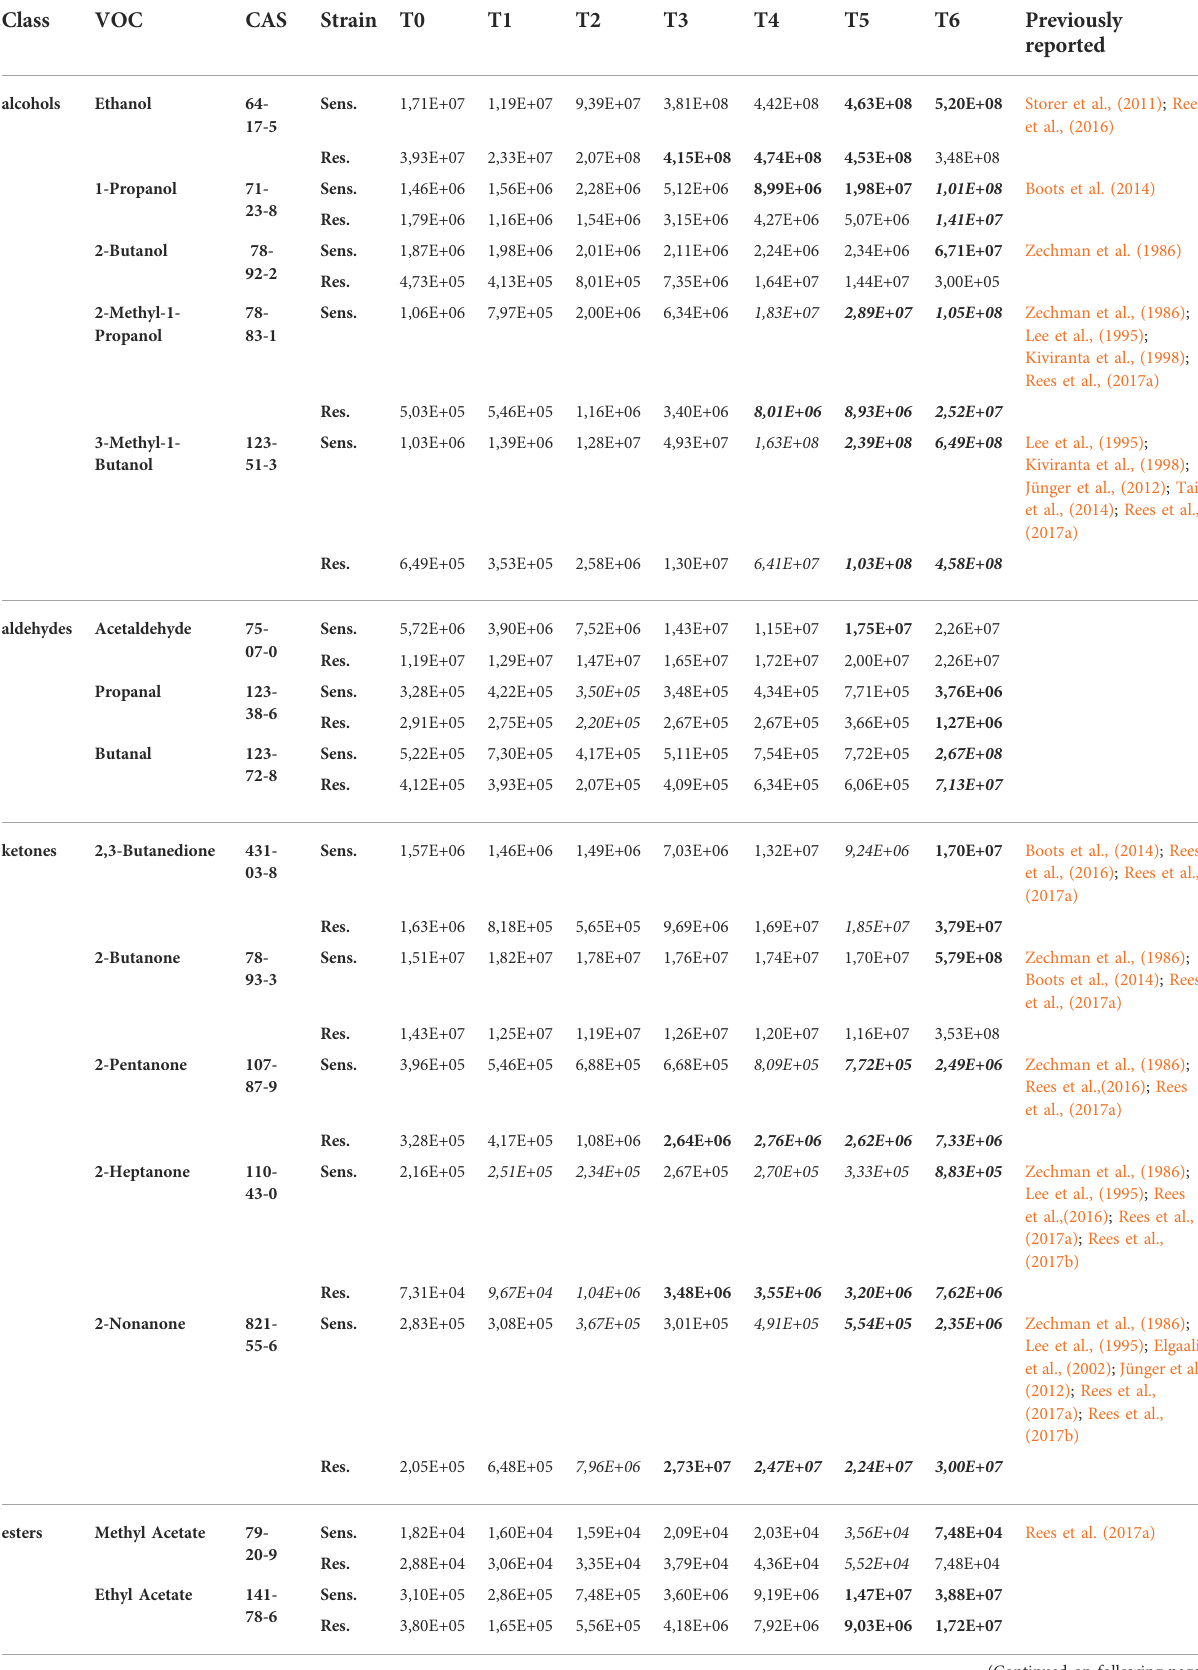
TABLE 2 VOCs with the release pro fi le directly related to the bacteria